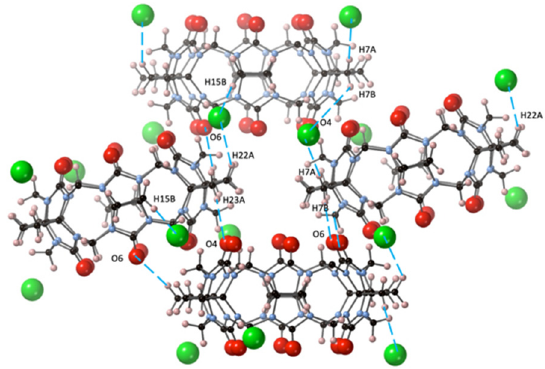
Figure 3. In structure 2, the CyB 6 Q[6] outer surface dipole connections (– –) are shown between C=O and cyclobutano CH 2 and these same protons and the Cl − ion (green).